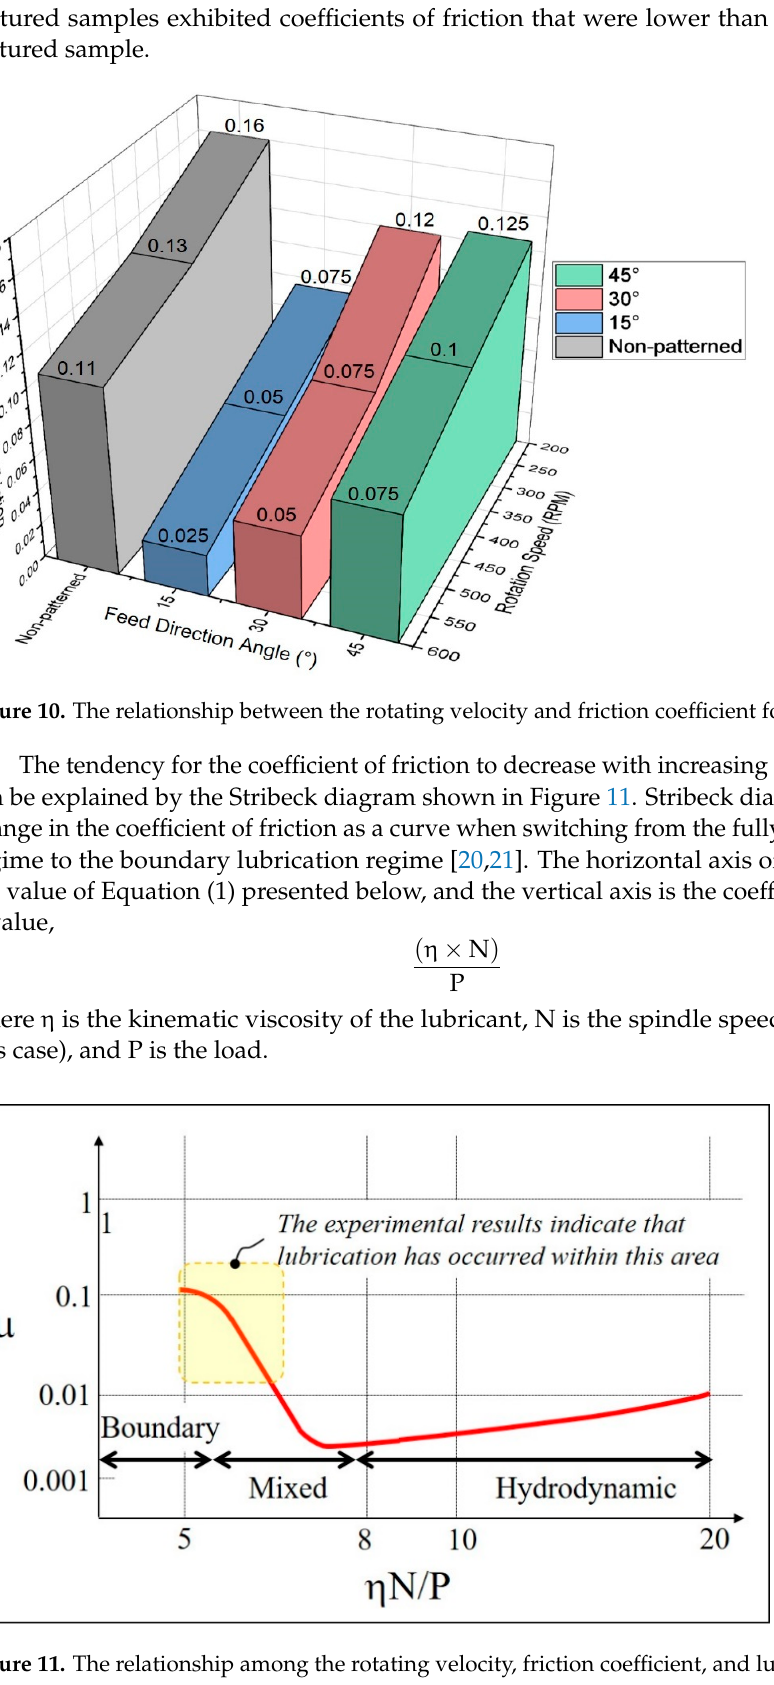
Figure 12. Coe ffi cient of friction due to changes in traverse speed of the micro-AAJ nozzle during machining at 200 rpm.